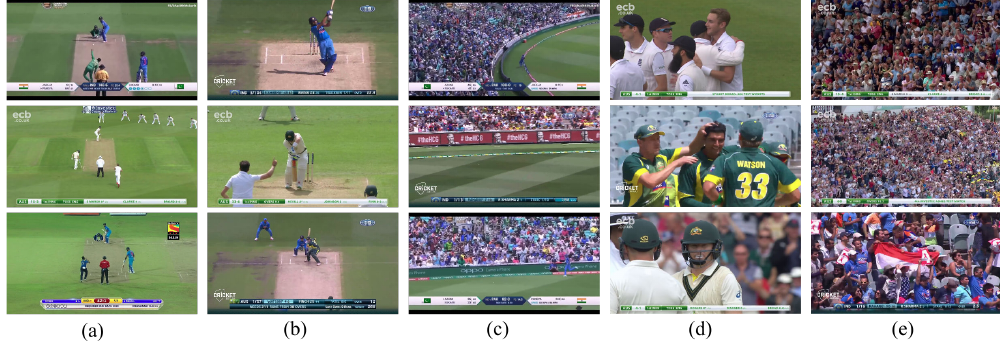
Figure 3. Scene classes, ( a ) Bowling, ( b ) Batting, ( c ) Boundary, ( d ) Close-up, and ( e ) Crowd.